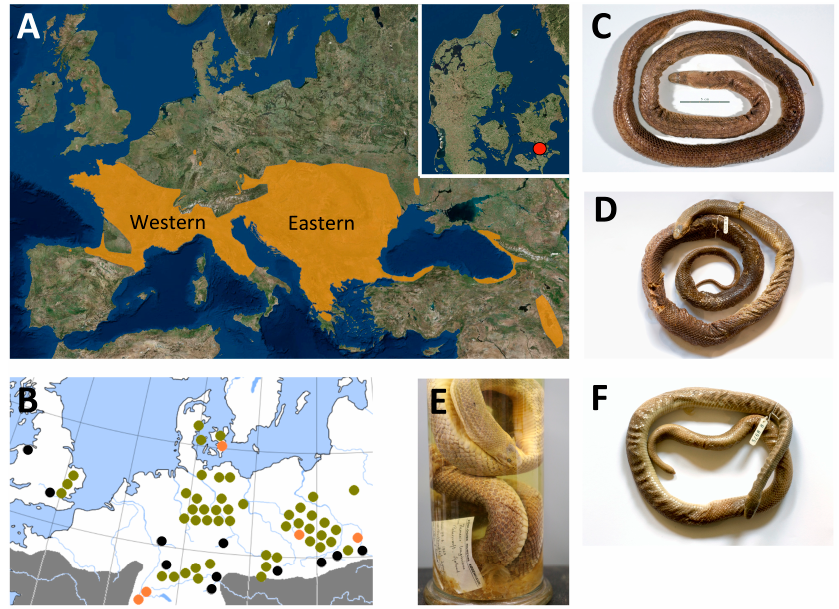
Figure 1. A: the main distribution of Z. longissimus (downloaded and modified from iucnredlist.org) , highlighting the Eastern and Western genetic clades identified in Musilová et al. [19] and the extinct Danish population from Southern Zealand (map insert). B : the current relictual (continent) or introduced (UK) populations marked with black dots. Populations that went extinct in historical times are marked with orange dots and fossil finds are marked with green dots. Modified from Gomille [6], Richter and Noe-Nygaard [11], and Kristensen [12]. Three historical Danish specimens were sampled for this study: C : HK2489, D+E : ZMUC R8974, F : ZMUC R8975. Photos: N. Ioannou and M.E. Allentoft.